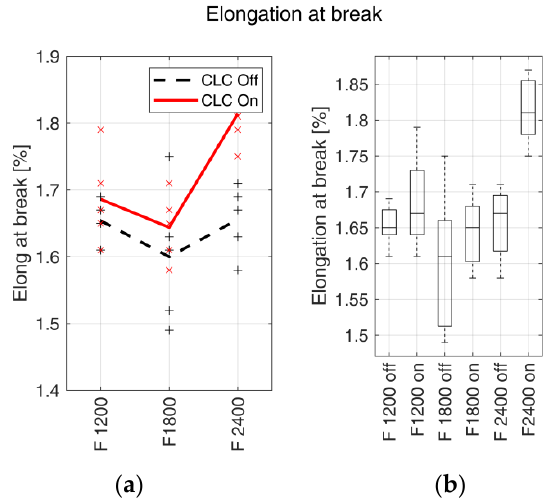
Figure 8. Elongation at break. ( a ) ε max trends with respect to the fabrication feed rates (expressed in mm/min). Markers indicate the measured values for each test, and bold lines indicate the mean values. The continuous red line indicates the samples realised with enabled CLC, and the black dashed line indicates the samples realised with disabled CLC. ( b ) Box plots of ε max vs. filament feed rate with enabled (on) and disabled (off) CLC